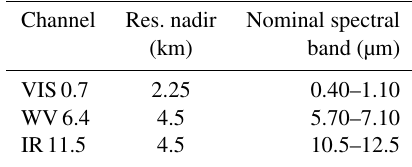
Table 2. Spatial and spectral characteristics of MVIRI visible (VIS), thermal infrared (IR), and water vapour (WV)